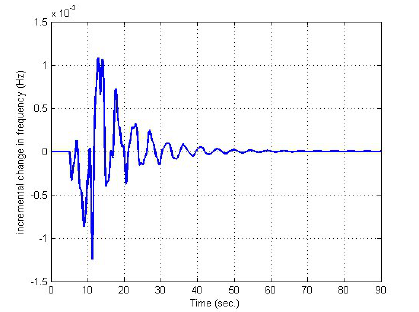
Fig. 13: Frequency deviation of area-2 (Case 3)